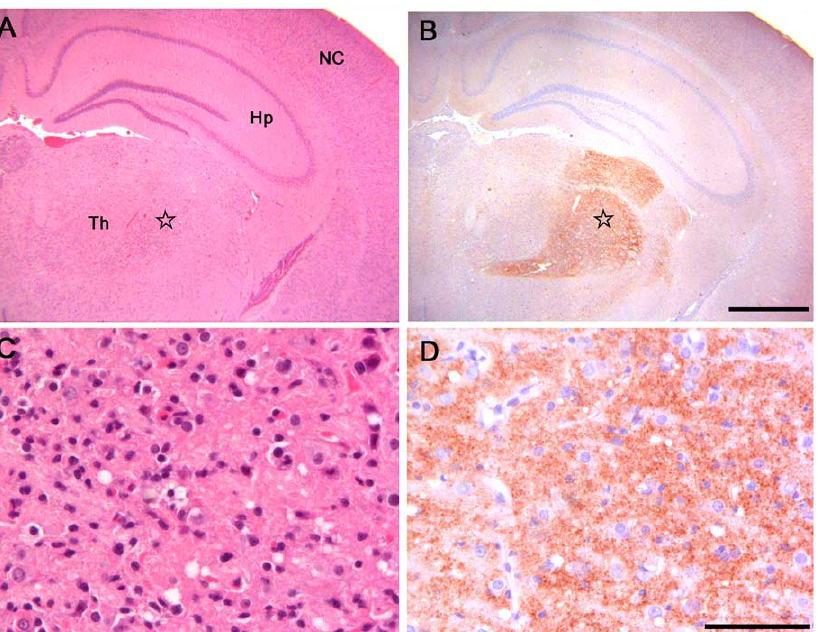
Figure 1. Histopathological and immunohistochemical analysis of Bv109I inoculated with Bv 109I CWD. (A) Serial sections showing neocortex (NC), hippocampus (Hp) and thalamus (Th), stained by haematoxylin and eosin and (B) by immunohistochemistry for PrP Sc with SAF84 mAb - bar 500 m m. (C) and (D): magnification of the ventral thalamic nucleus (star) from (A) and (B), respectively - bar 50 m m.